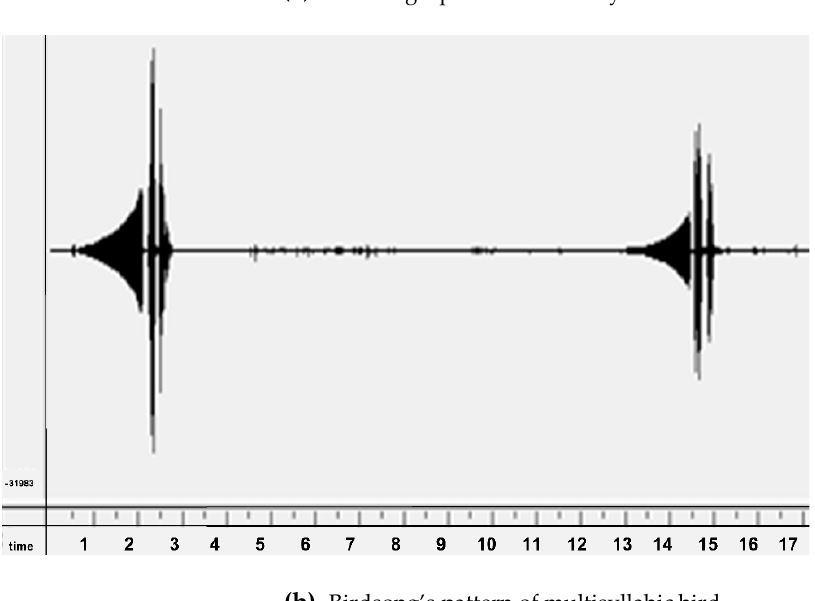
Figure 2. The waveform of birdsongs. ( a ) Birdsong’s pattern of monosyllabic bird; ( b ) Birdsong’s pattern of multisyl- labic